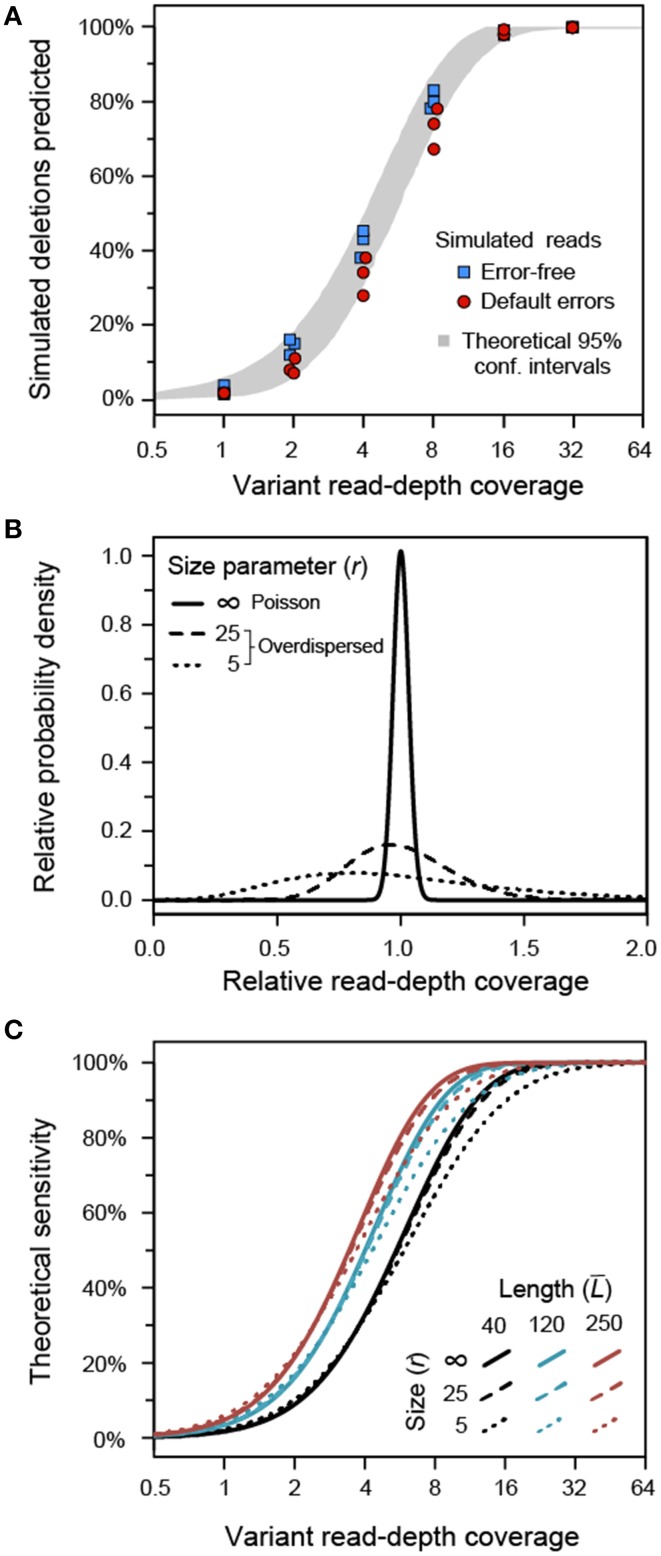
Sensitivity of variant junction detection. (A) Illumina read data sets with 100-fold read-depth coverage were simulated for population samples consisting of a mixture of an E. coli reference genome and a variant genome with 100 random deletions. The average read-depth of the variant genome within the sample determined how many of these deletions were detected. In data sets in which no simulated sequencing errors were present in the reads (blue squares), the number of deletions detected matches theoretical calculations based on the requirement that there be at least three spanning reads and the random distribution of the simulated reads across the genome (95% confidence intervals in gray). When typical Illumina sequencing errors were simulated (red circles), the sensitivity was slightly decreased, presumably because some errors prevent a read from mapping or aligning adequately to be counted as support for a new prediction of a variant junction. The precision of the algorithm on all of these model datasets was 100% (there were no false-positive predictions). (B) Distributions of variant genome coverage that would be observed at different positions in a genome given an average value of one for different values of the negative binomial size parameter (r) representing overdispersion due to biases in coverage at different sites. An idealized Poisson distribution representing no bias is shown at r = ∞. (C) Theoretical sensitivity of the algorithm employed by breseq for detecting variant junctions as a function of read length (line color) and negative binomial distribution size parameter for coverage bias (line dash style). These calculations assume completely error-free reads.